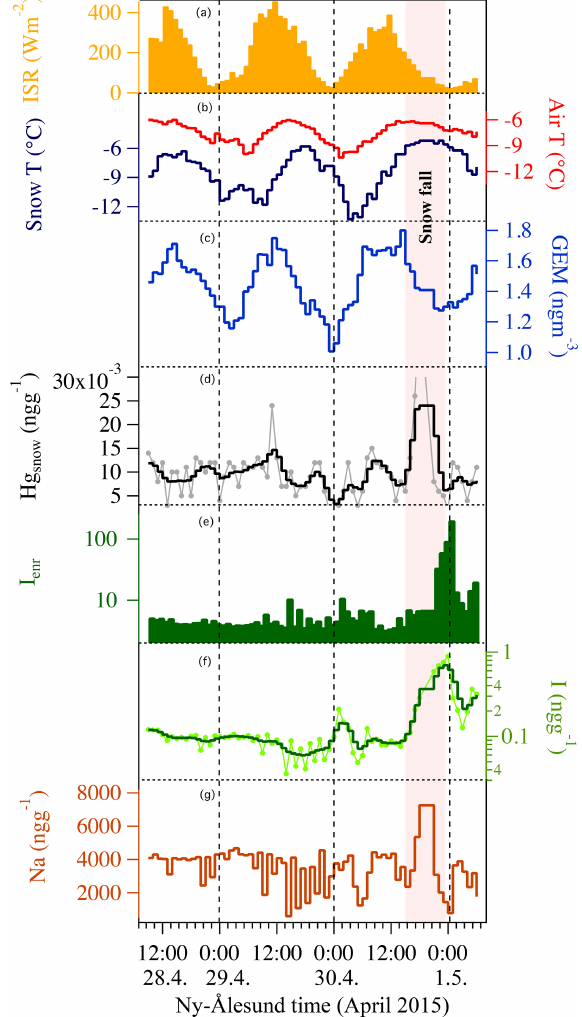
Figure 2. The 2015 experiment: continuous light conditions. The hourly sodium ( g – dark red) concentrations are connected with io- dine concentrations ( f – light green for the raw data and green for the three-point smoothing) except during the snowfall where the signals decouple. Iodine enrichment ( e – dark green) demonstrates the ef- fect of snowfall on iodine concentration in surface snow. Gaseous elemental mercury ( c – blue) exhibits a diurnal pattern, while to- tal mercury in surface snow ( d – grey line and black line three-point smoothing) does not. Snowfall occurrence is highlighted by the pink shading. Snow and air temperature ( b – dark blue and red) show the diurnal cycle connected with incoming solar radiation (ISR) ( a – solid yellow). Wind speed is not shown since it was almost constant during the entire experiment. Dashed vertical lines indicate local